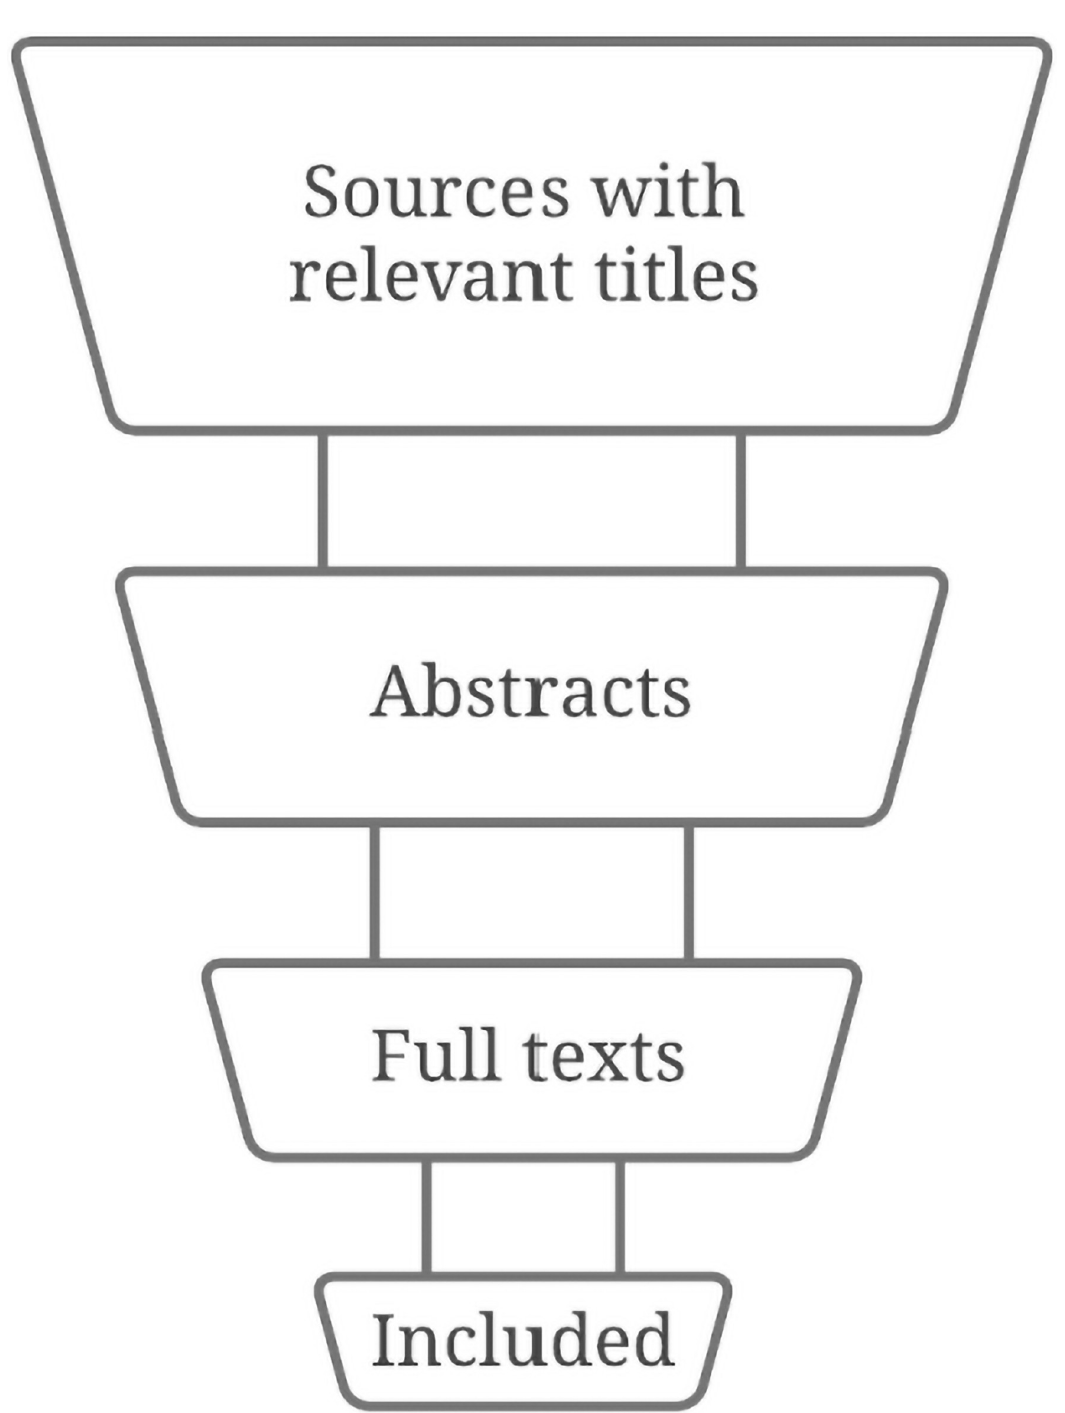
Fig 2. The search flow will funnel sources into progressively smaller collections.